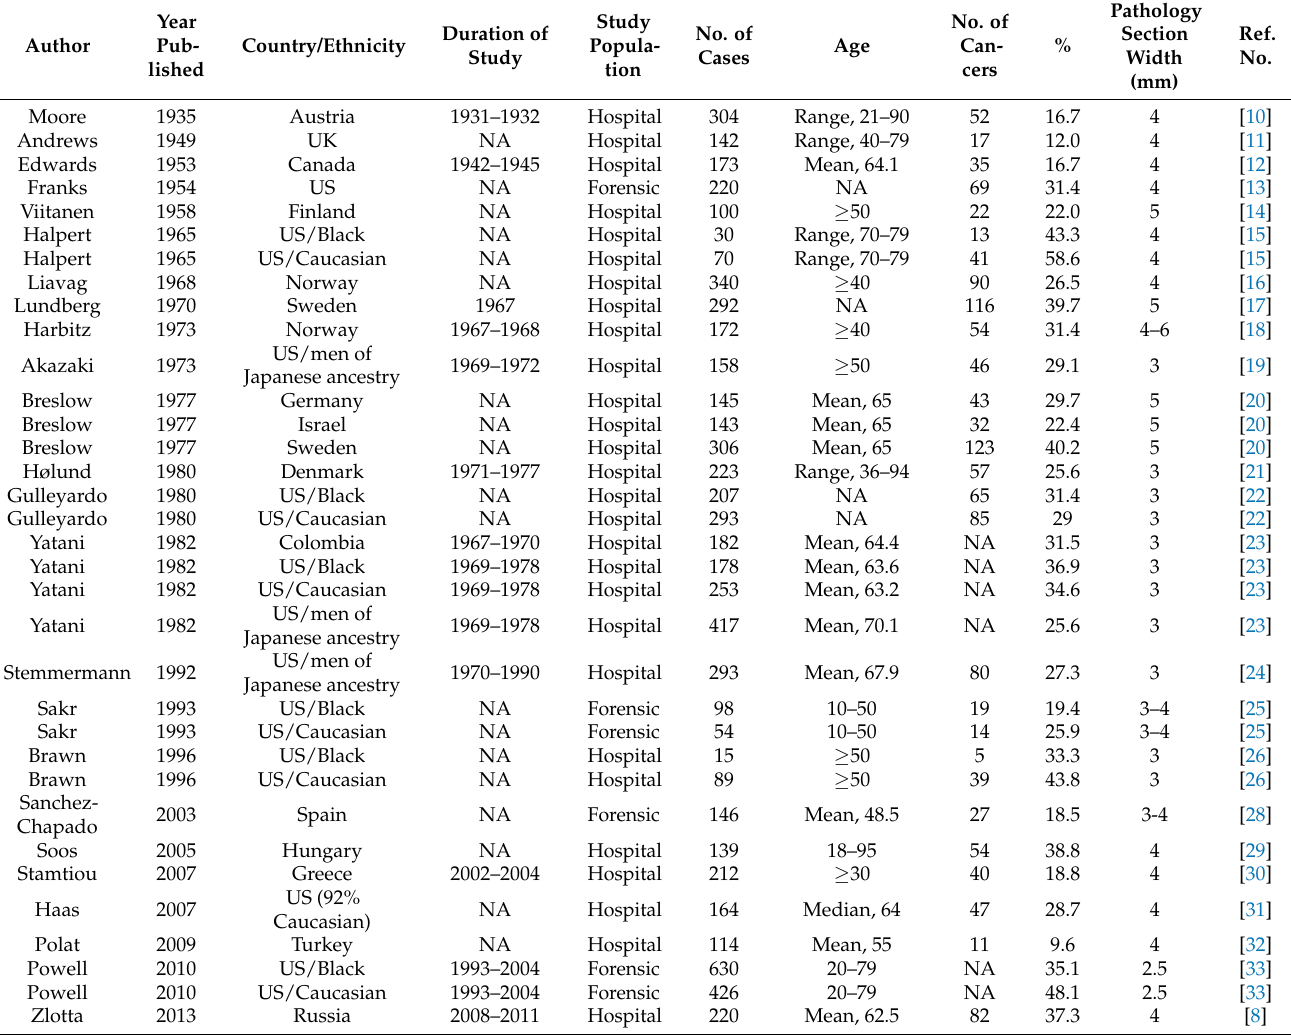
Table 1. Studies evaluating latent PC by step-sectioning of prostate in the US and